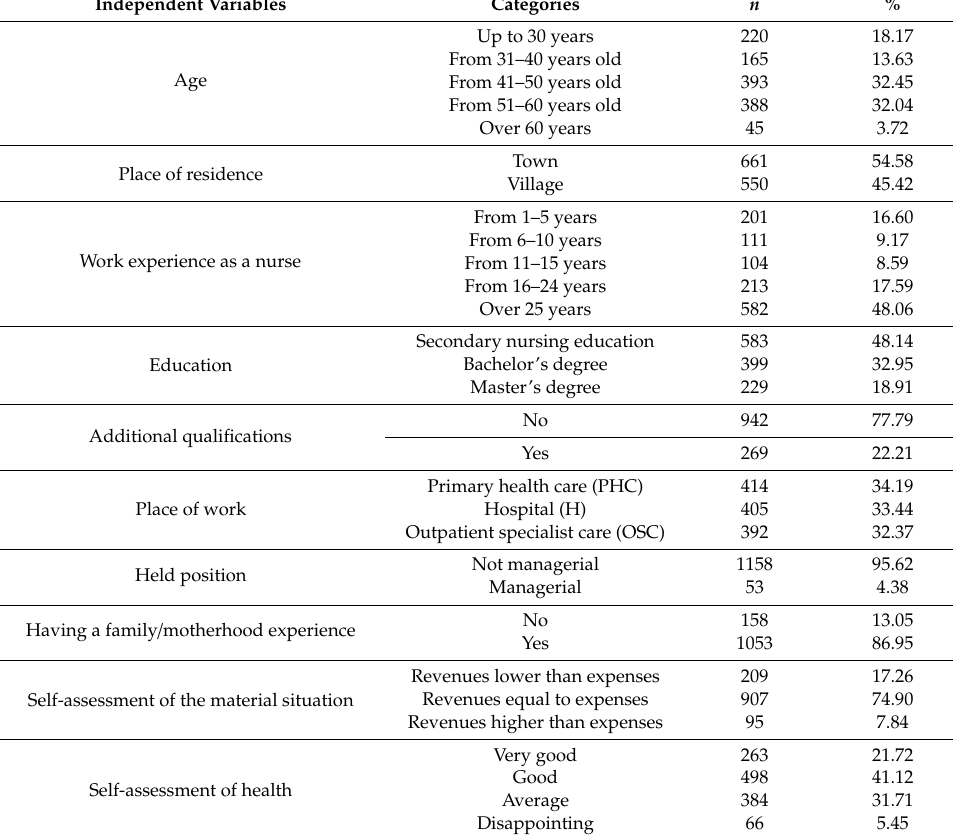
Table 1. Characteristics of the studied